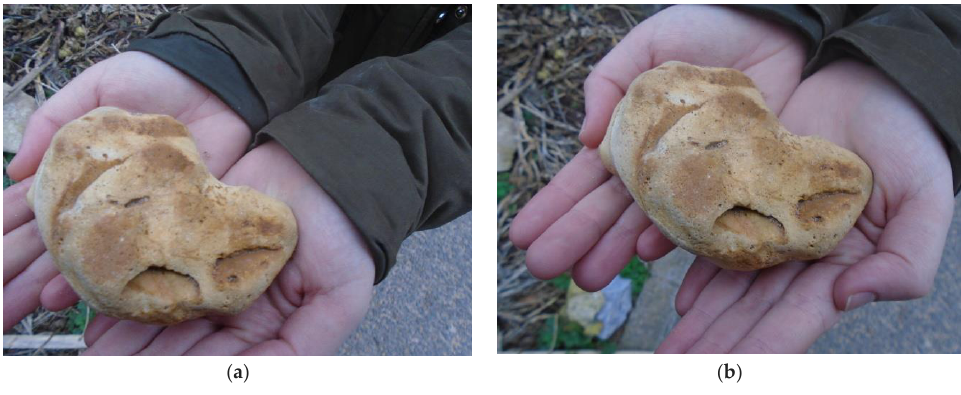
Figure 17. ( a ) Focus on hand; ( b ) Focus on stone.